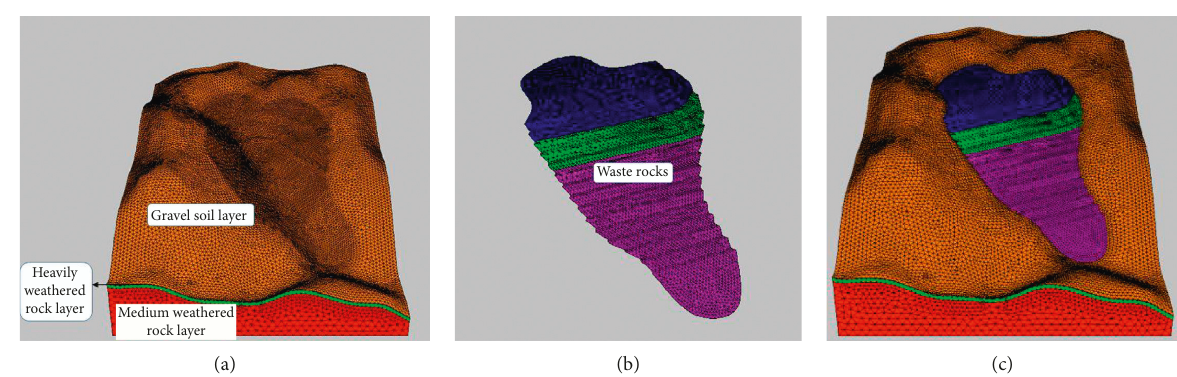
Figure 6: 3D numerical analysis model of waste dump. (a) Waste dump before dumping process. (b) Waste rocks scheduled to be dumped. (c) The waste dump after dumping process.